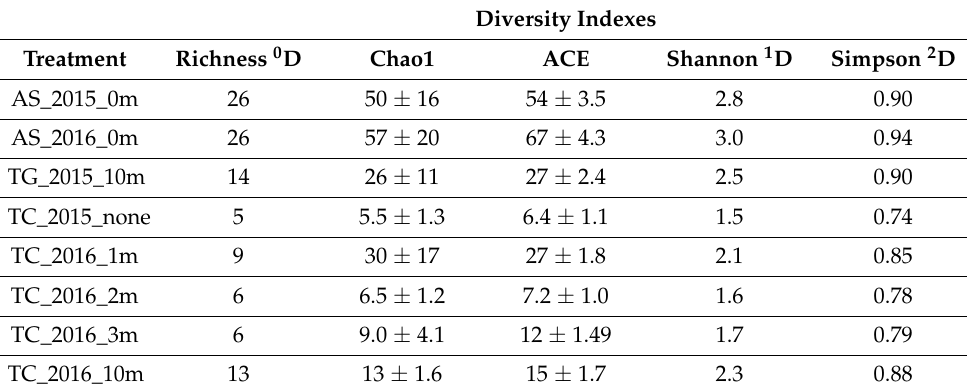
Table 1. Ecological diversity indexes of the ECM fungal OTUs according to all treatments. The names of the treatments include the host species (AS: A . spirorbis ; TG: T . guillainii ; TC: T . calobuxus ), the year of sampling (2015 or 2016) and the distance of sampling from A . spirorbis , expressed in meters (where none correspond to TC grown in nursery). The estimated and asymptotic richness index 0 D counts species equally without considering their relative abundance, the Shannon diversity index 1 D counts species in proportion to their abundance, and the Simpson diversity index 2 D discounts all but the dominant species in the assemblage. Diversity Indexes